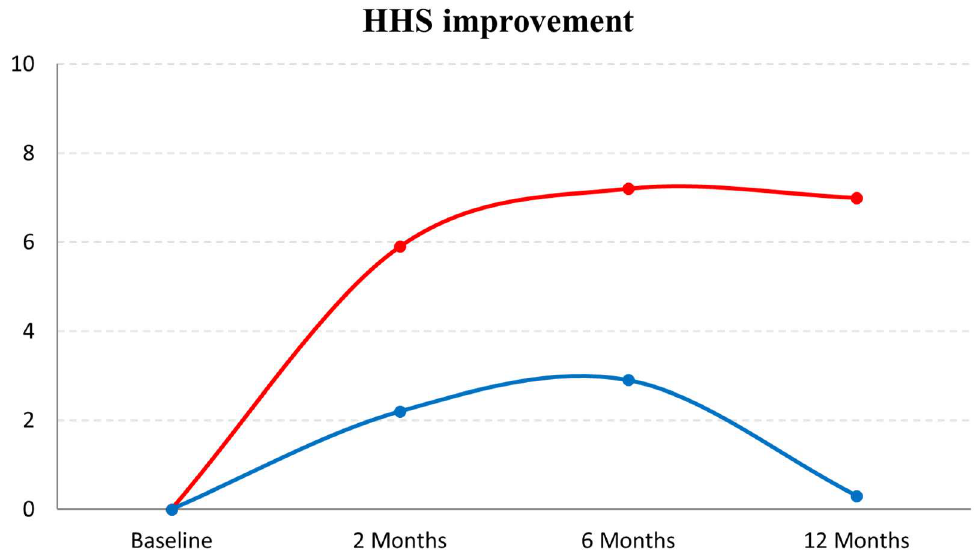
Figure 6. Improvement of the Harris Hip Score (HHS) in patients with Tonnis 1-2. The C-PRP group (red) reported a higher clinical improvement compared with the A-PRP group (blue) at 12 months of follow-up ( p = 0.049).